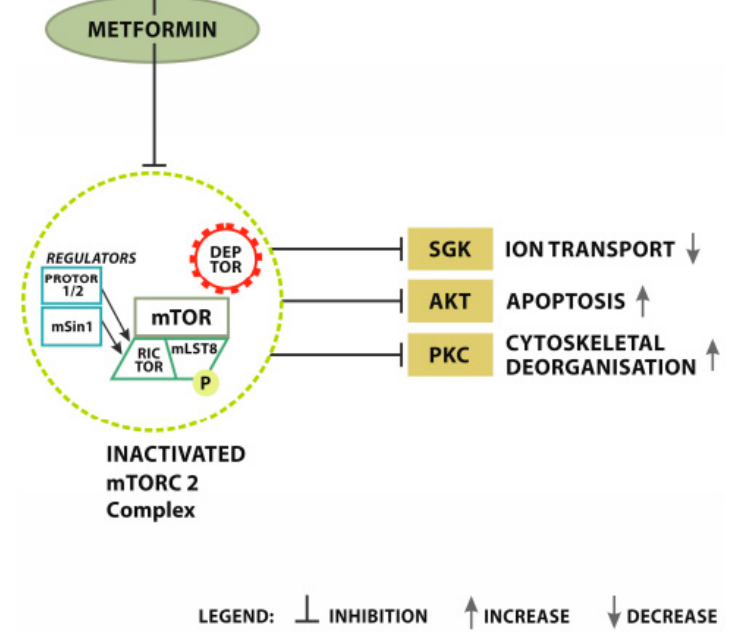
Figure 3. Metformin signaling-mTORC2 inhibition. MET inhibits mTORC2 directly. Inactivated complex limits further typical signaling. Transference restrictive signals from MET on mTORC2 result in the inhibition of SGK (serum and glucocorticoid-induced protein kinase), AKT (serine / threonine-protein kinase), and PKC (protein kinase C) related pathways. MET induced inactivation of mTORC2 results in SGK inhibition. SGK limitation significantly reduces ion transport. AKT inhibition consequently leads to apoptosis and PKC restriction accelerates cytoskeletal deorganisation.